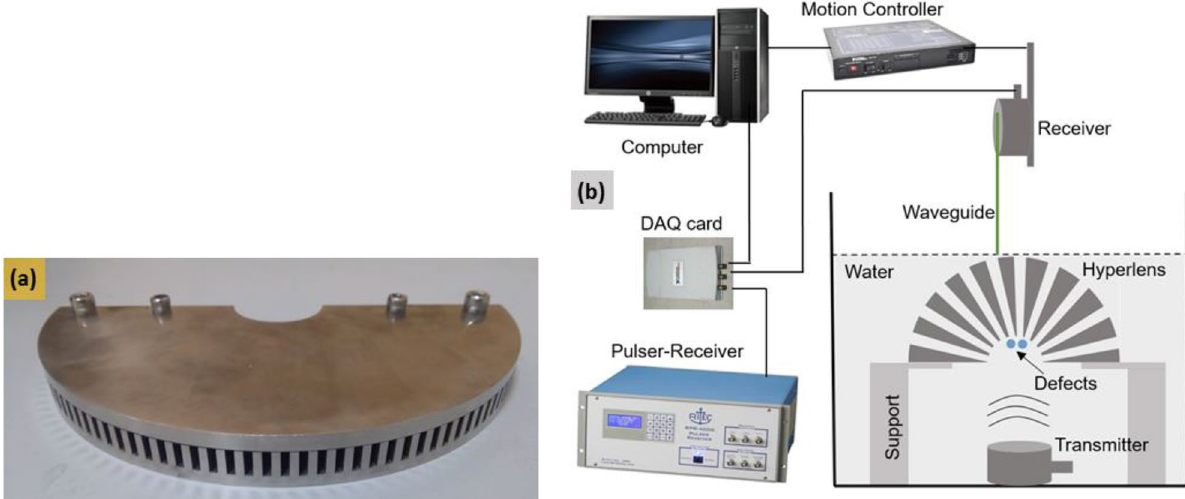
Figure 10. ( a ) Photograph of the metallic hyperlens used in experiments and ( b ) Schematic illustration of the experimental